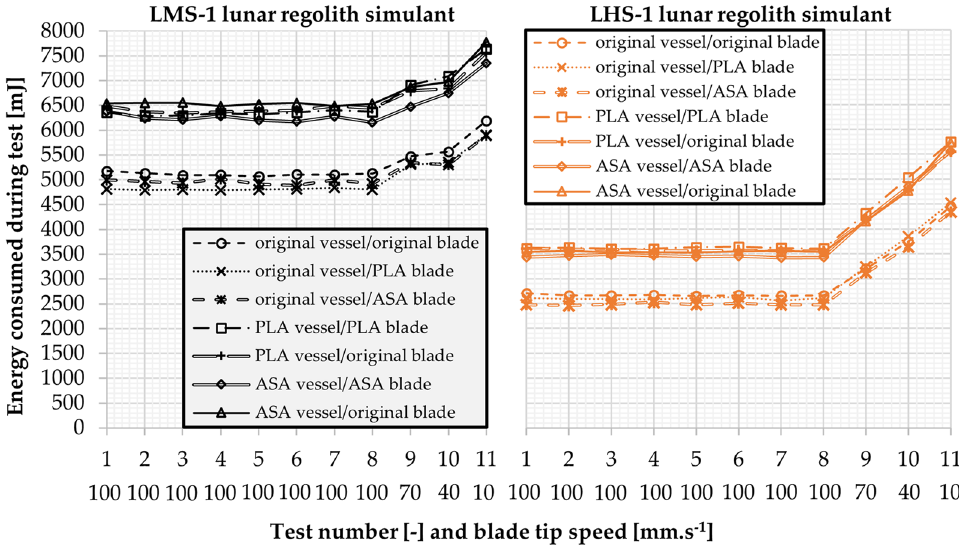
Figure 8. Average results for the Stability Index, Flow Rate Index and Basic Flowability Energy standardized tests—left LMS-1,—right